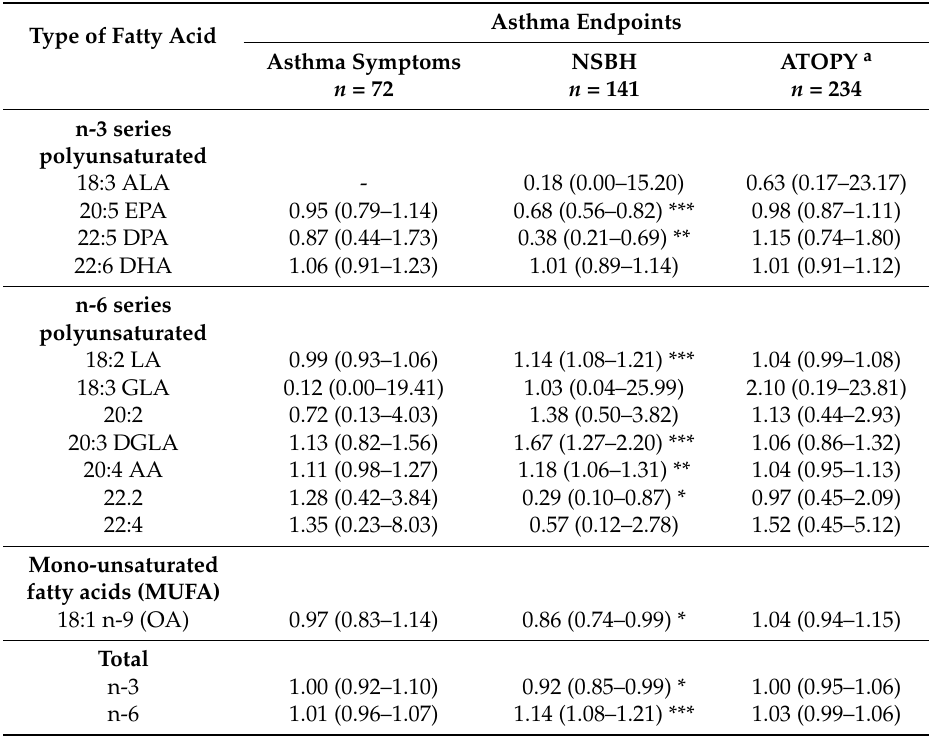
Table 5. Unadjusted logistic regression models for asthma endpoints in relation serum phospholipid (% weight) among fishing village inhabitants along the West Coast of South